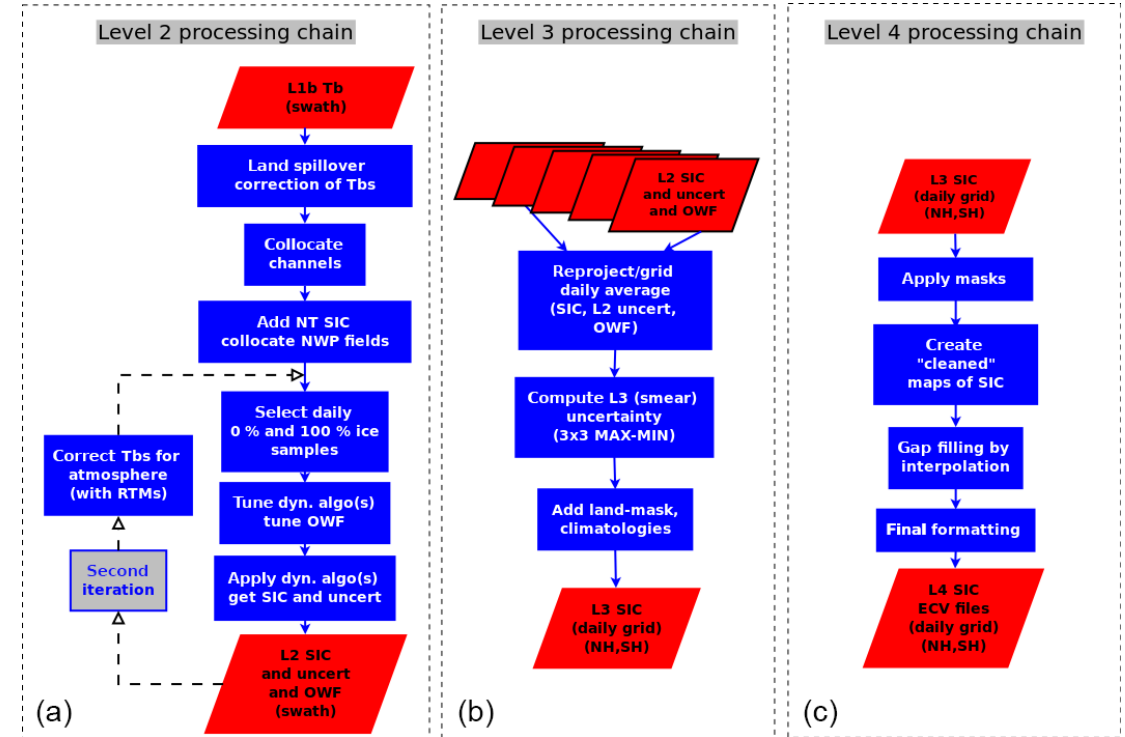
Figure 2. From (a) to (c) , the three main elements (Level 2, Level 3, and Level 4) in the sea-ice concentration (SIC) processing workflow. The red boxes depict data files, the blue boxes correspond to individual steps (a.k.a. algorithms) in the processing. The files that exit a processing chain (e.g. the “L2 SIC and uncert and OWF” at the bottom of the Level 2 processing chain) are the input for the next level of processing. Acronyms: NT is the Nasa Team algorithm, OWF is open-water filter, RTM is radiative transfer model, uncert stands for uncertainty, L2 is Level 2, L3 is Level 3, L4 and is Level